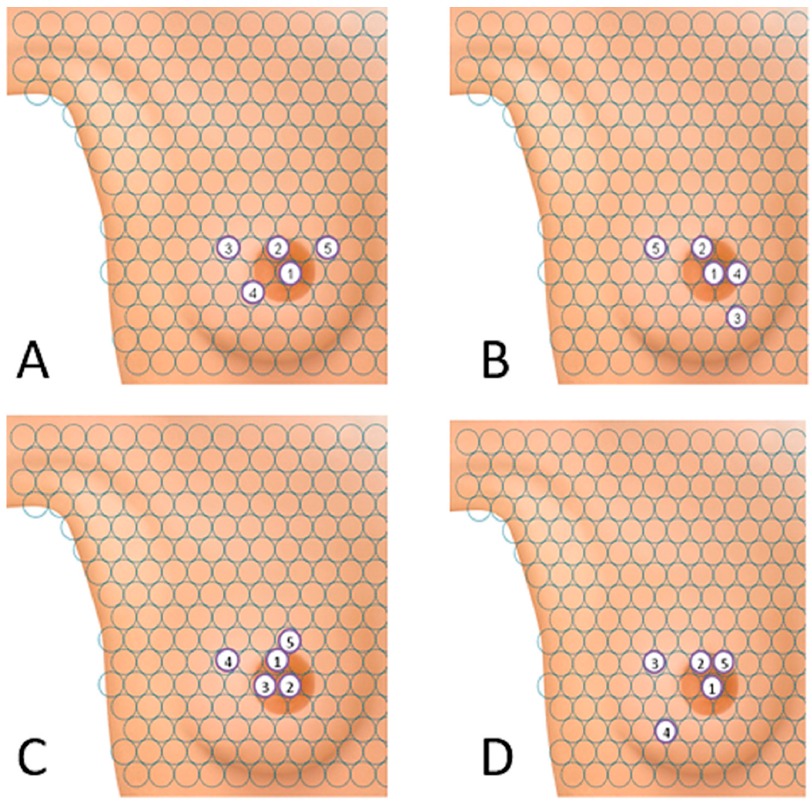
Figure 7. Points from which the breast examination was most often initiated in the proprietary interactive tactile test: ( A ) study group—Test I, ( B ) control group—Test I, ( C ) study group—Test II and ( D ) control group—Test II.